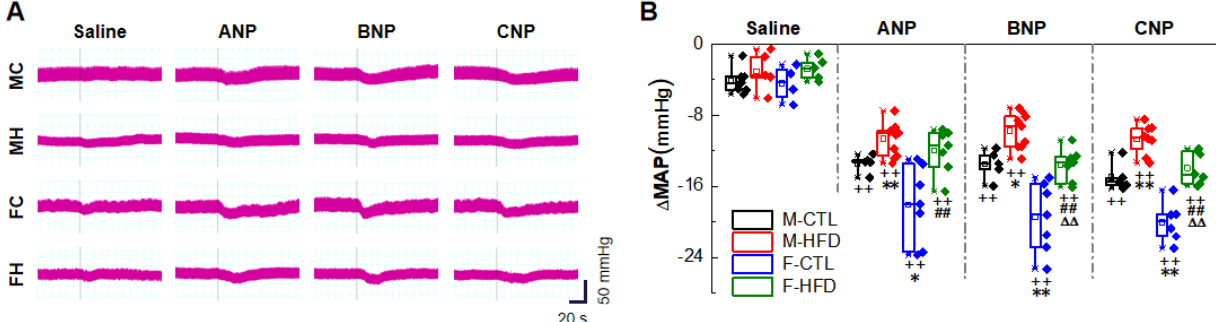
Figure 3. Blood pressure (BP) reduction effects of natriuretic peptides (NPs) under hypertensive